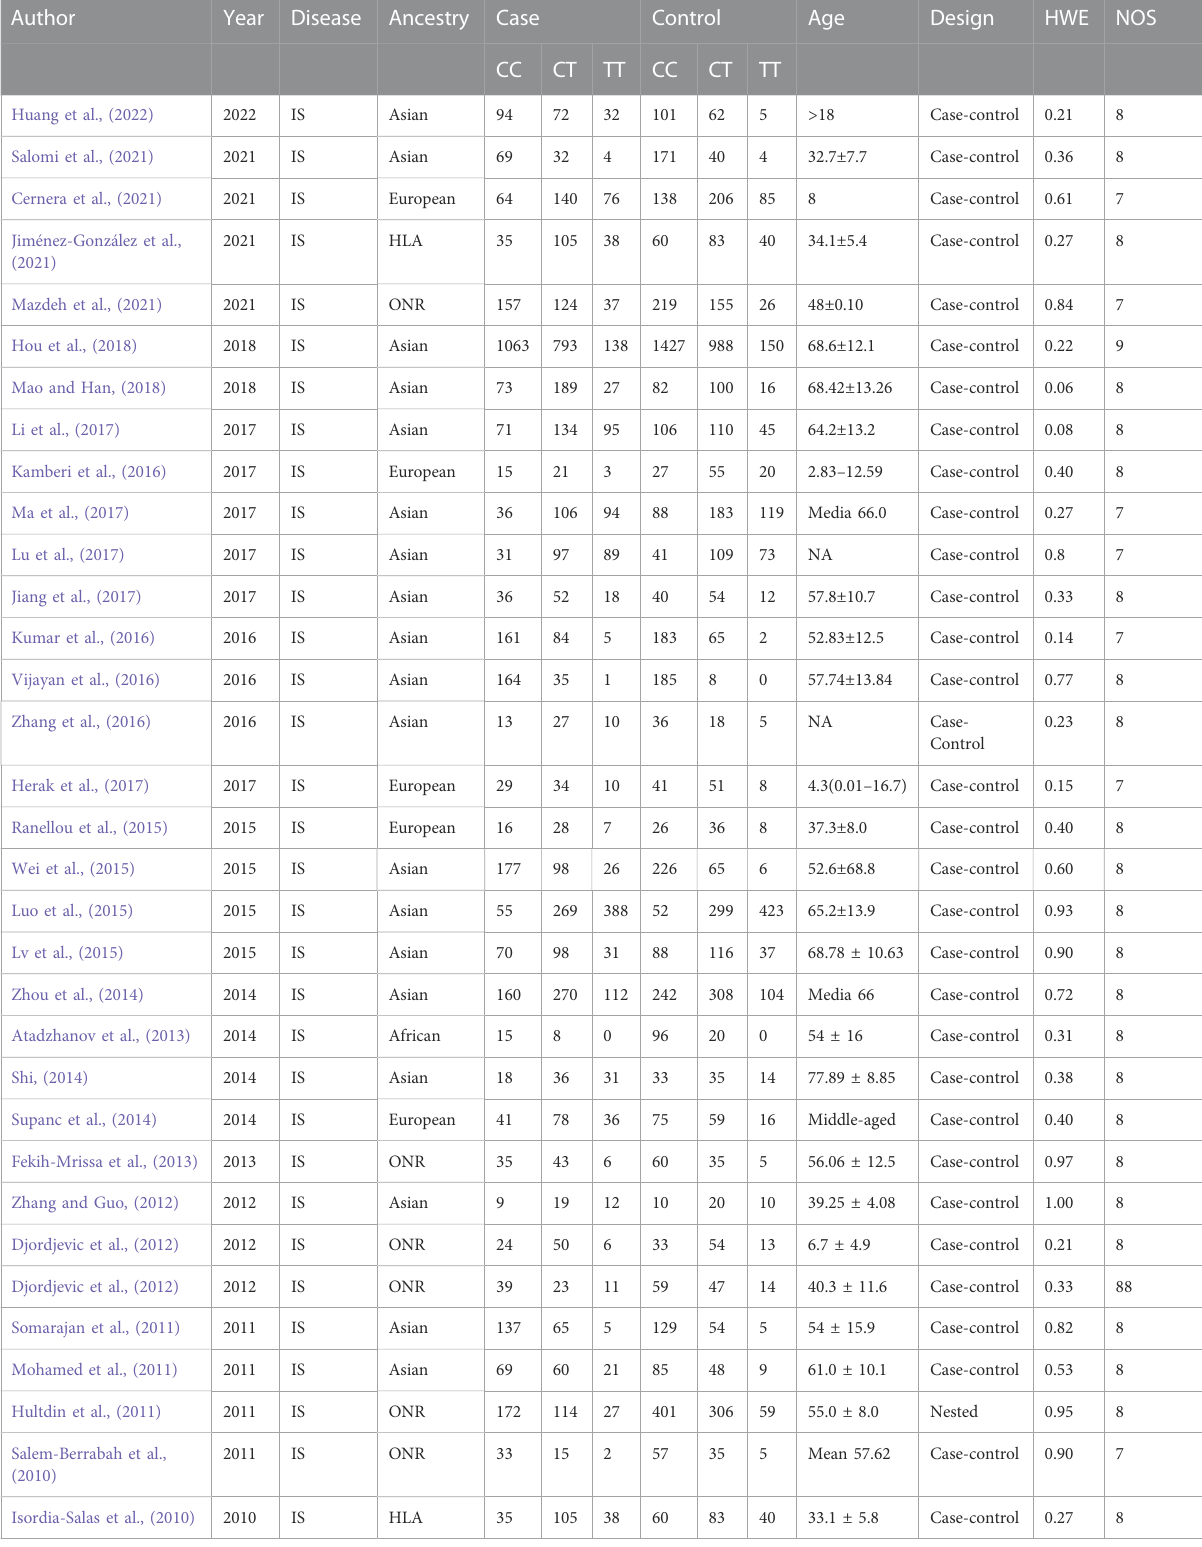
TABLE 1 Characteristics of studies included in the